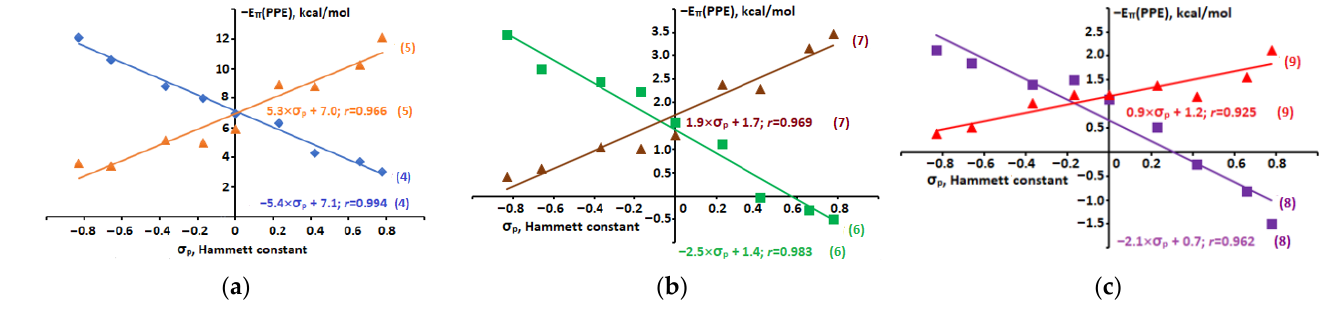
Figure 7. Dependence of the − E π (PPE) values on the σ p Hammett constants for subseries Ia,b with the double bond as the π‐ bridge ( a ), subseries IIa,b with the para ‐ phenyl ring as the π‐ bridge ( b ) and subseries IIIa,b with the meta ‐ phenyl ring as the π‐ bridge ( c ).